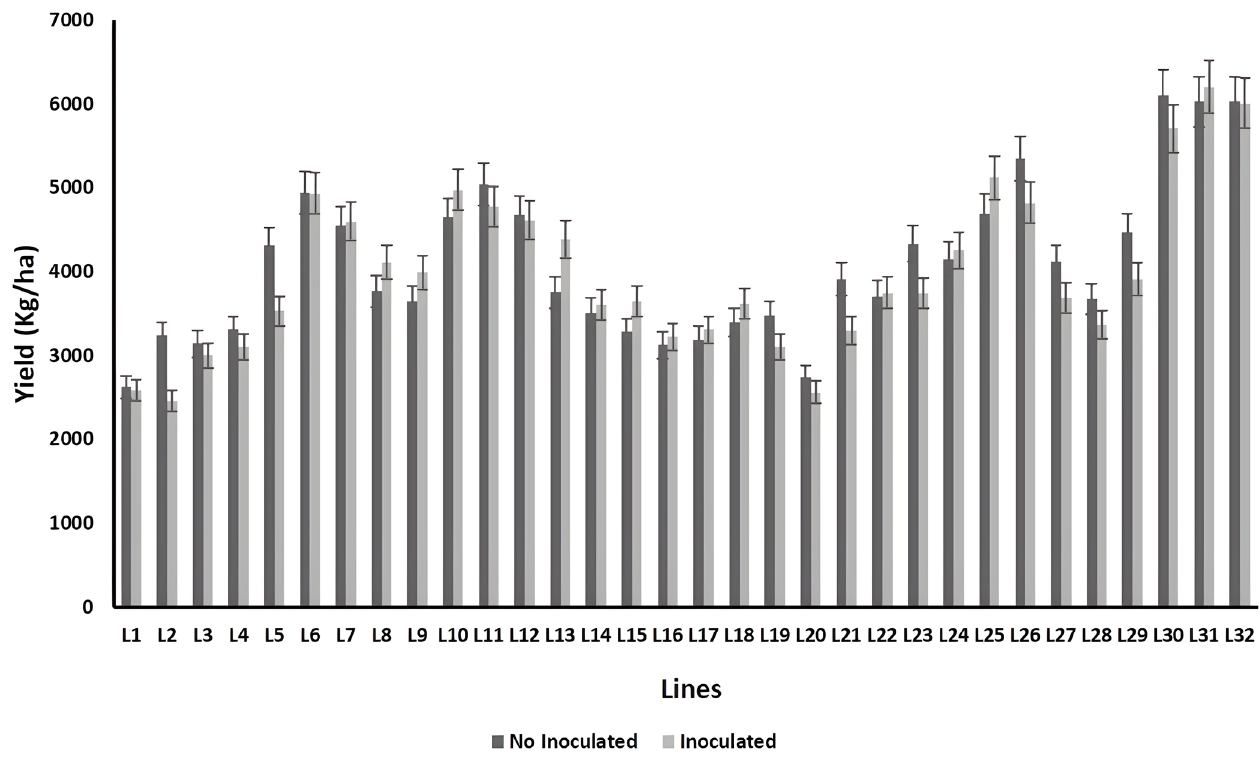
Figure 4. Grain yield of 32 CIMMYT’s spring wheat lines, including 6 check lines, inoculated and Fusarium culmorum , in Konya, noninoculated with Fusarium culmorum , in Konya, Turkey. noninoculated with